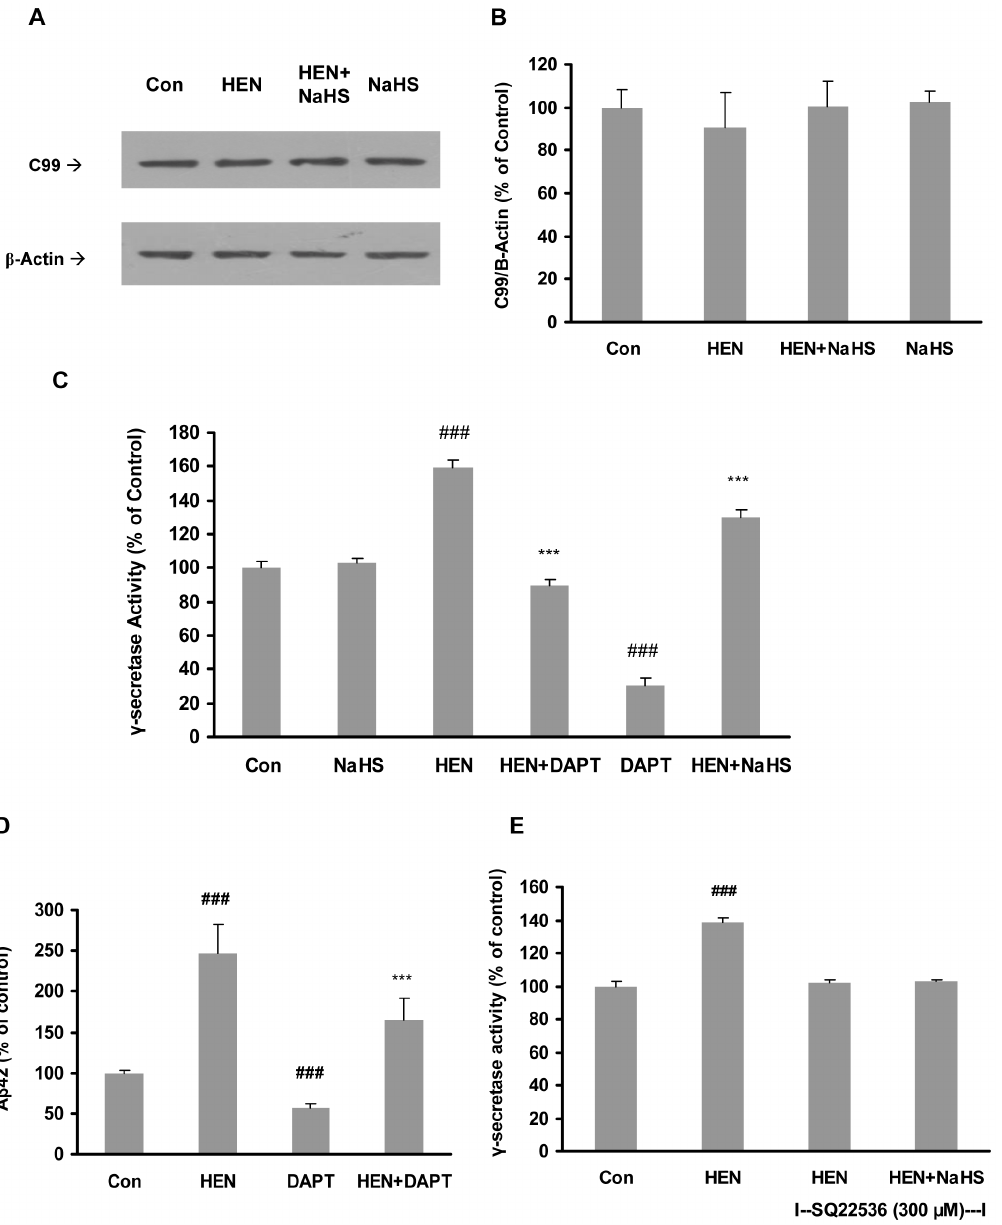
Figure 7. Effect of NaHS on activities of b - and c -secretases. A–B : Representative gel (A) and quantitative analysis (B) showing NaHS (25– 100 m M, 12 hours) and HENECA (100 nM, 24 hours) failed to affect b -CTF (C99) expression in SH-SY5Y cells. The membrane fractions were analysed by western blot with antibody against c-terminal fragment of APP (C99) or b -actin. C–D :Effect of NaHS (100 m M) and a c -secretase inhibitor, DAPT (1 m M, 1 hour) on HENECA (100 nM)-stimulated c -secretase activity (C) and A b 42 formation (D) in SH-SY5Y cells expressing APPswe. E : Effect of NaHS (100 m M) on c -secretase activity in SH-SY5Y cells preincubated with AC antagonist, SQ 22536 (300 m M). Data are given as means 6 S.E.M, n=4–6. ### p , 0.001 vs Con group; *** p , 0.001 vs HEN group. Con, control; HEN,